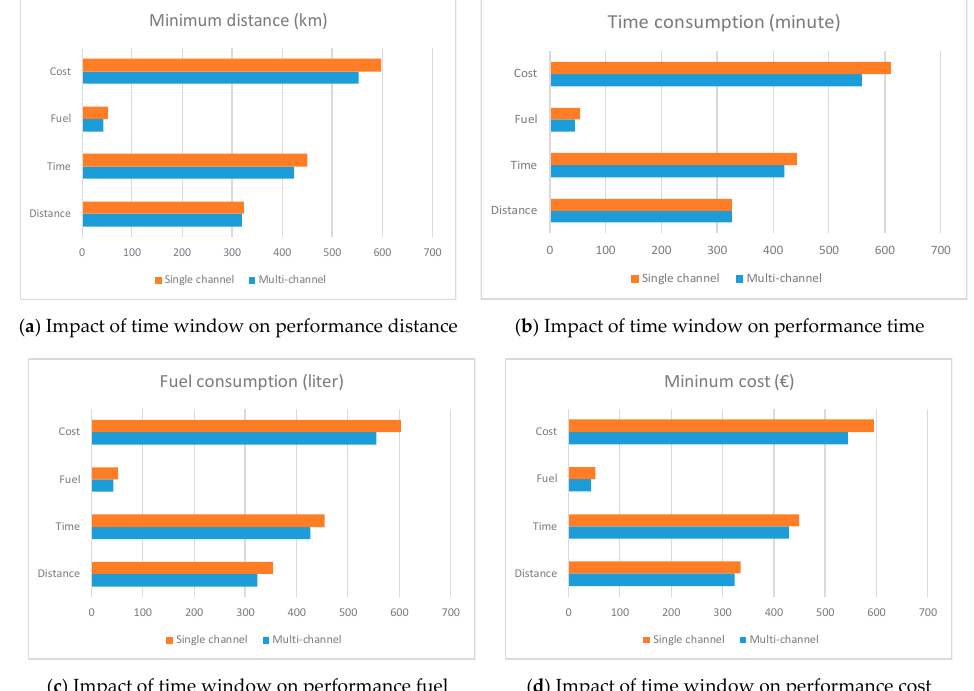
Figure 3. Channel selection impact on performance indicators.